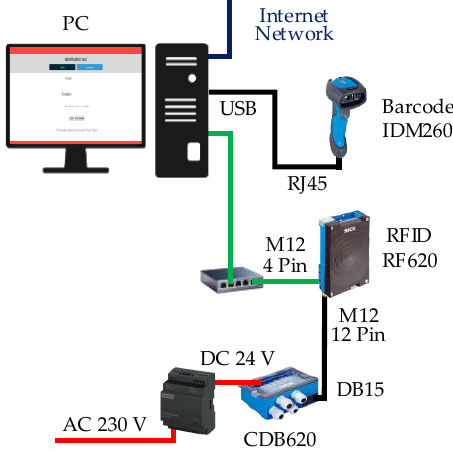
Figure 3. PC Platform connections.